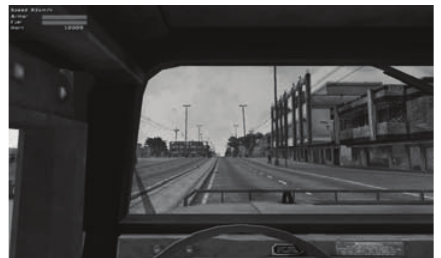
Figure 1: Serious gaming environment: low threat zone.